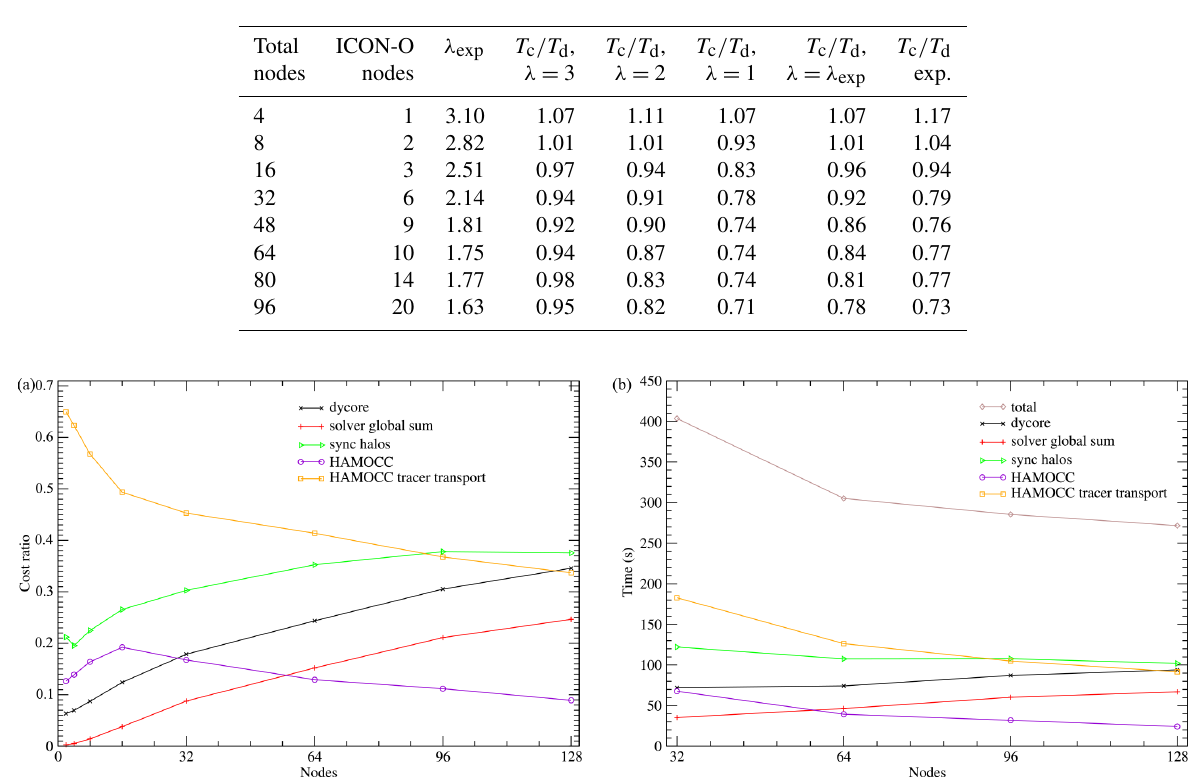
Table 1. The first two columns describe the nodes used for the ICON-O–HAMOCC concurrent setup. Columns 4–6 describe the estimated ratio of concurrent to the sequential time T c /T d calculated using Eq. (1) and the relative efficiency for different values of λ from the sequential runs. In column 3 λ = λ exp is computed from the sequential runs and in column 7 the estimation of the T c /T d ratio for this λ through interpolation. In the last column the actual T c /T d is computed from the runs.